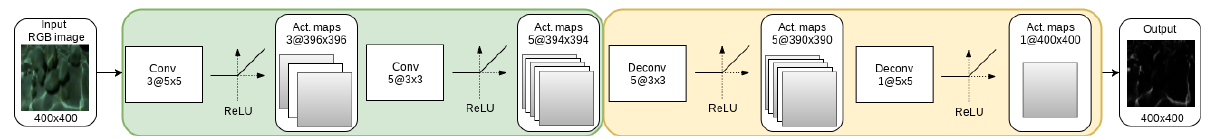
Figure 1. SalienceNet: a 4-layer CNN consisting of 2 convolutional layers followed by 2 deconvolutional layers. A ReLU activation unit follows each [de-]convolution operation. All [de-]convolution kernels have size 3 ×